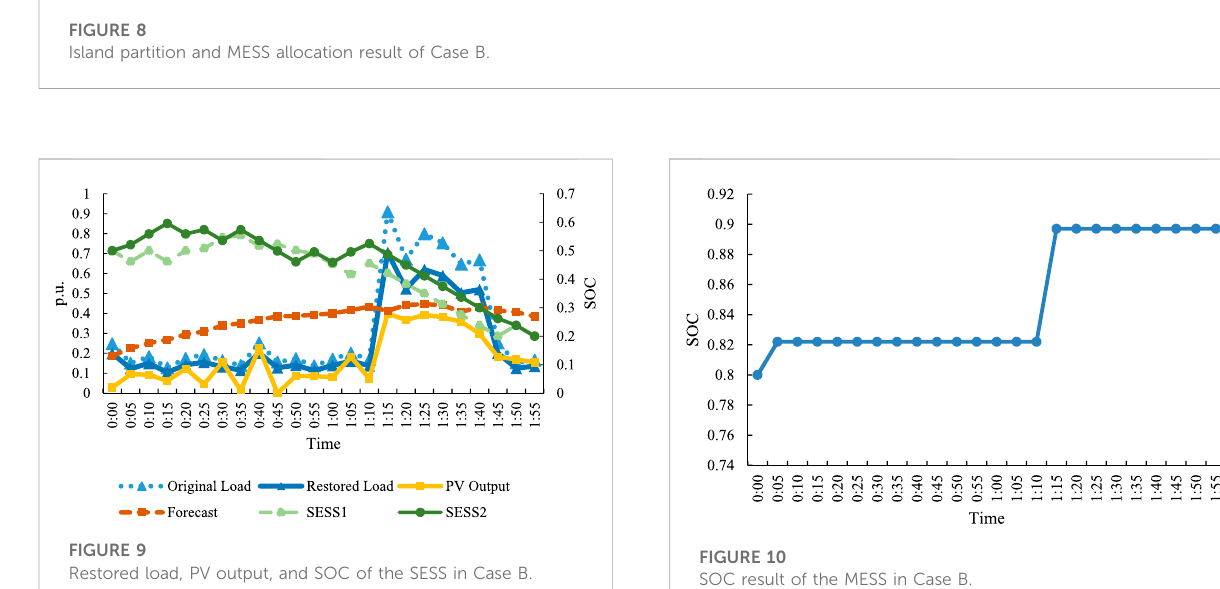
FIGURE 9 Restored load, PV output, and SOC of the SESS in Case B.